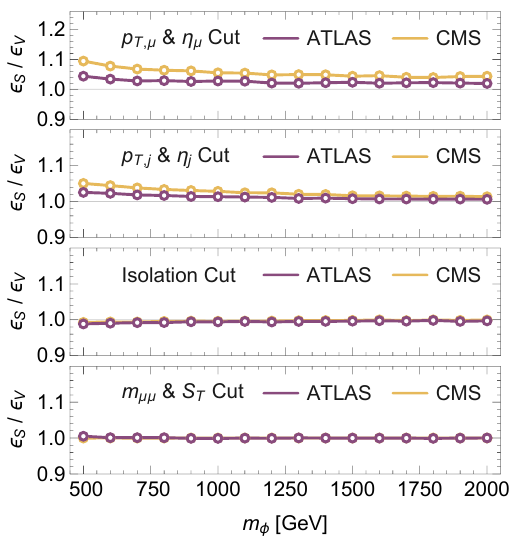
Figure 2 . Ratios of signal e(cid:14)ciencies (cid:15) S =(cid:15) V for pair-produced scalar and vector LQs with various masses. The LQ decays are to muons and jets. The panels show the relative e(cid:14)ciencies of a series of selection cuts from recent ATLAS [8] and CMS [9] analyses. Details of the cuts and plots of phase space distributions are in appendix